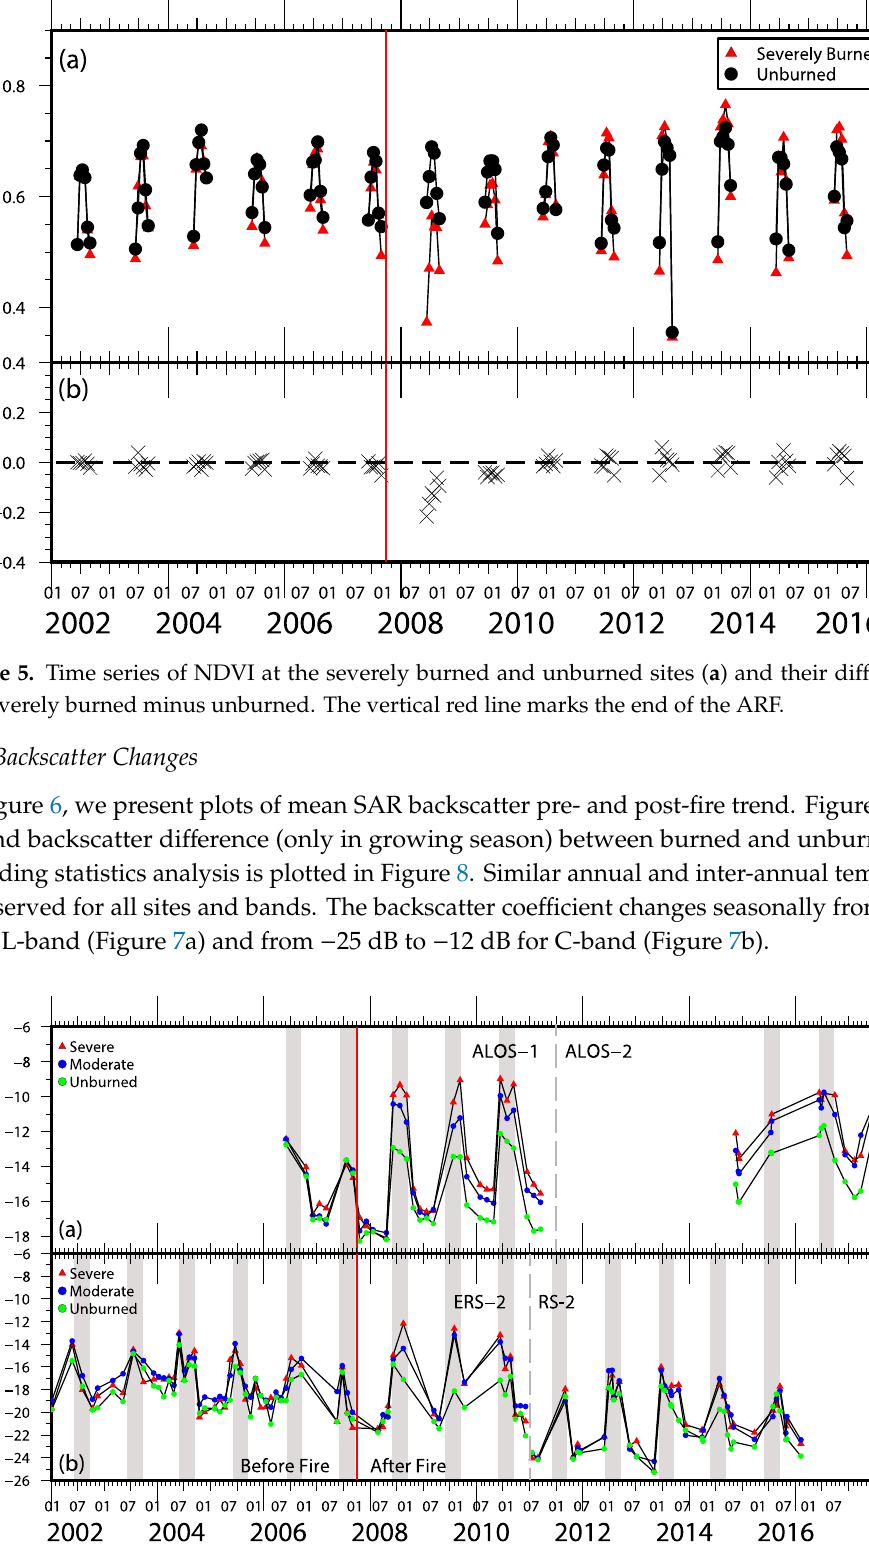
Figure 6. Time series of backscatter coefficients at the severely and moderately burned and unburned sites. ( a ) for ALOS-1 and ALOS-2, ( b ) for ERS-2 and RS-2. The red vertical line marks the end of the fire. The gray bars denote the growing seasons (June, July, August). The gray dashed lines separate ALOS-1 and ALOS-2 in ( a ), ERS-2 and RS-2 in ( b ).